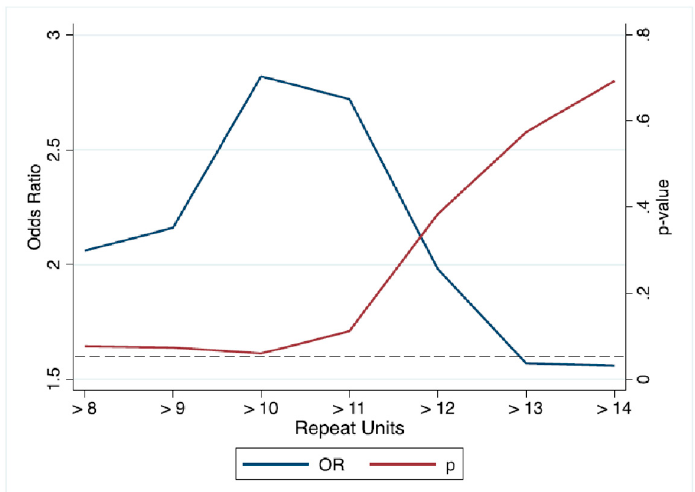
Figure 2. Results of univariate logistic regression analysis between COVID-19 cases and ALS patients at each intermediate allele size > 8 units. The blue line represents odds ratio (OR), the dark red line p -value, and the dotted gray line represents p = 0.05 significance level.